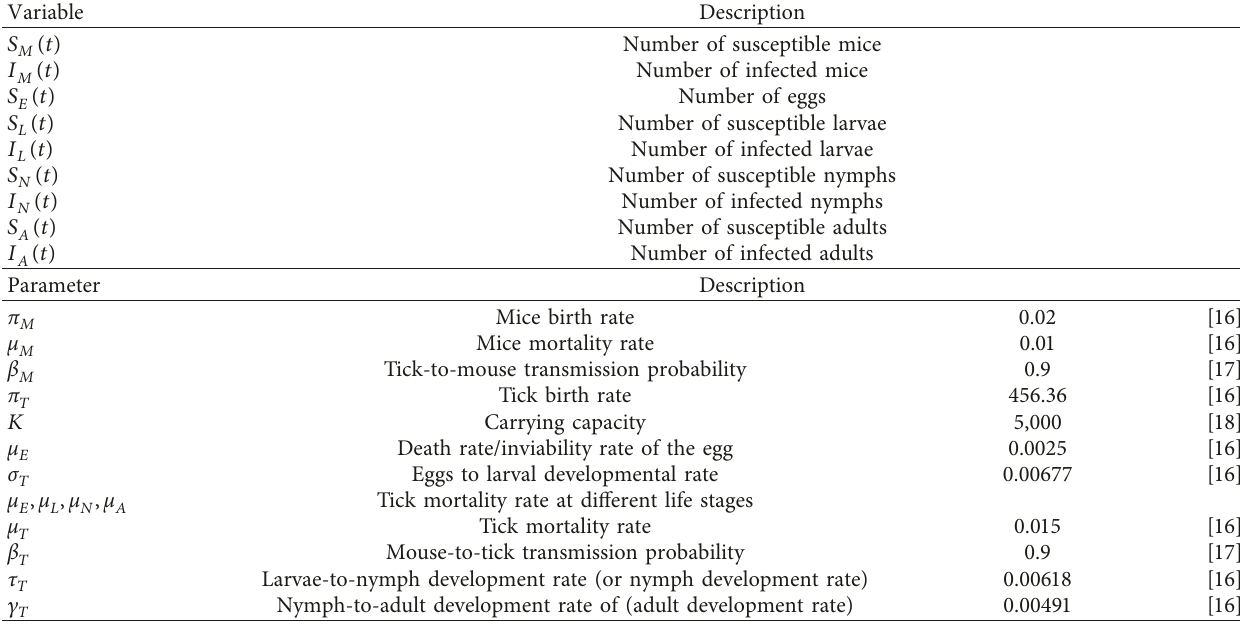
Table 1: Description of the variables and parameters for the Lyme disease model in Figure